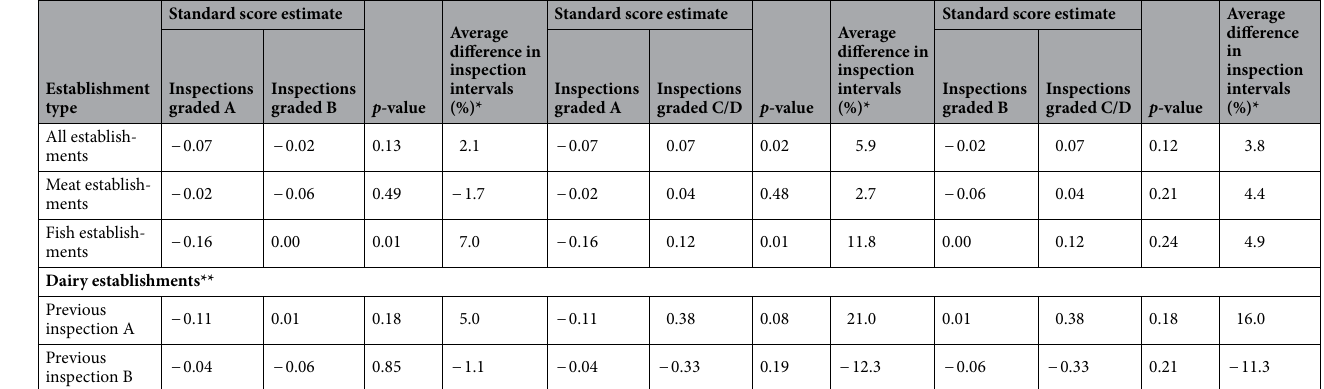
Table 3. Standard score estimates for pre-planned inspections resulting in grades A, B, and C or D. Estimates were calculated using generalized estimating equations. A higher standard score estimate denotes a longer previous inspection; results interpreted separately based on grade of the previous